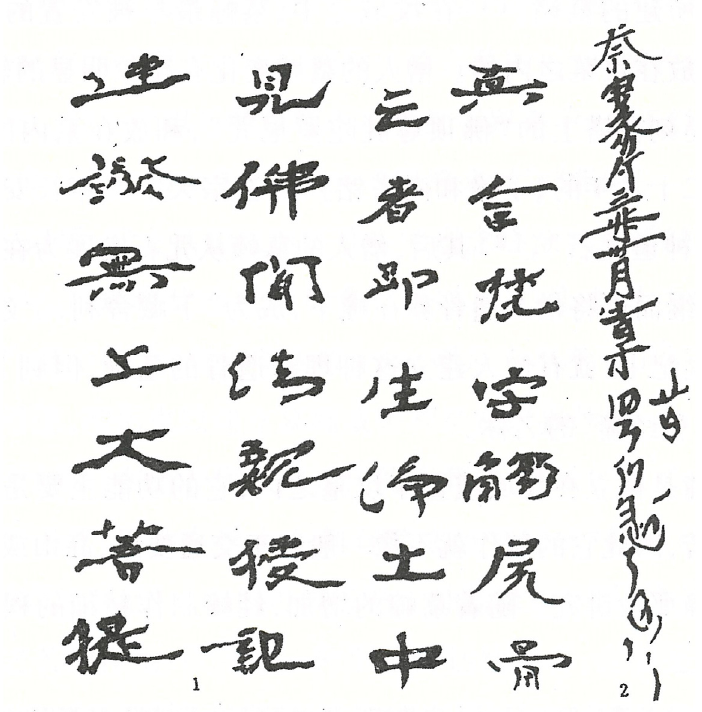
Figure 4. Facsimile of the ink inscription on the northern ceiling of the Liao Tomb at Aohanqi, Neimenggu Province of China. After (“Aohanqi” 1999, p. 91).